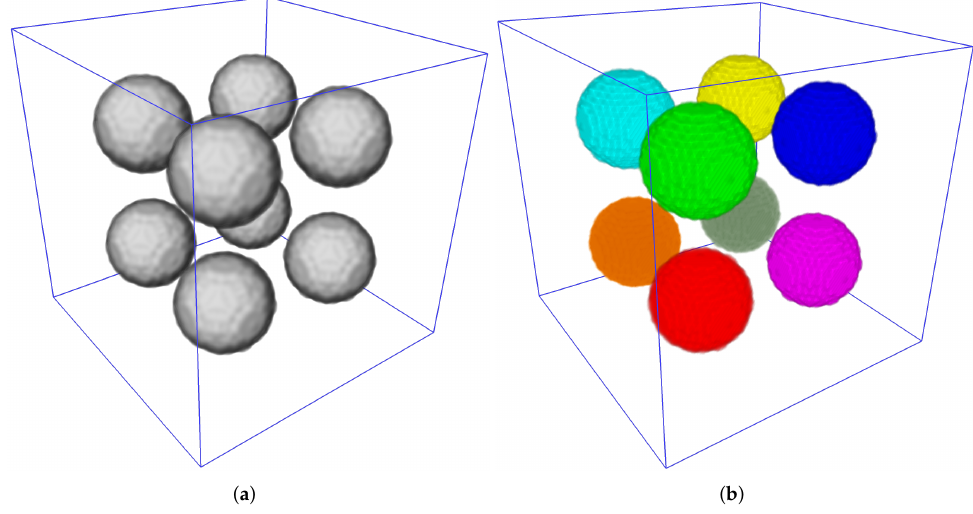
Figure 10. ( a ) 3D image containing balls. ( b ) Segmentation